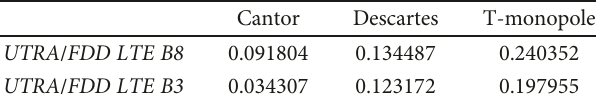
Table 2: Coverage factor in practical automatic tuning units. Cantor Descartes